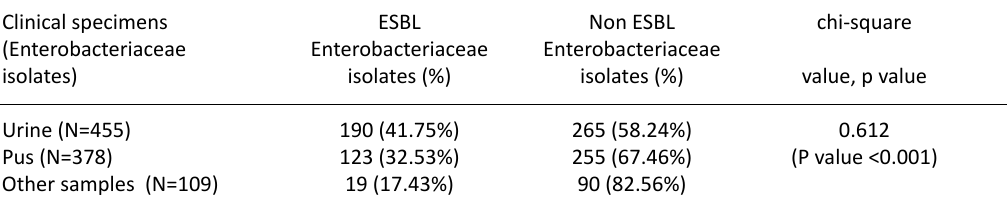
Table 3. Specimen wise distribution of ESBL and non-ESBL producing Enterobacteriaceae Clinical specimens ESBL Non ESBL